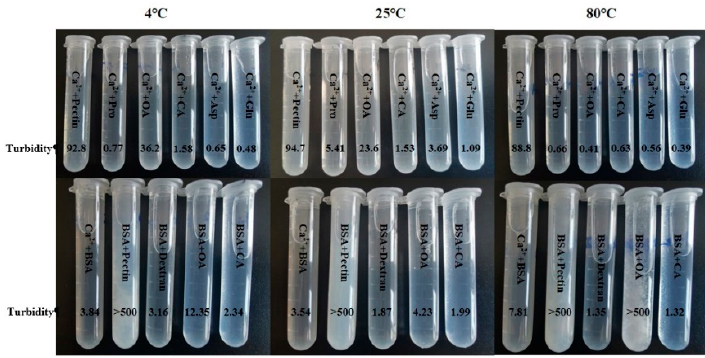
Figure 5. Turbidity of chemical composition interaction at different temperatures.